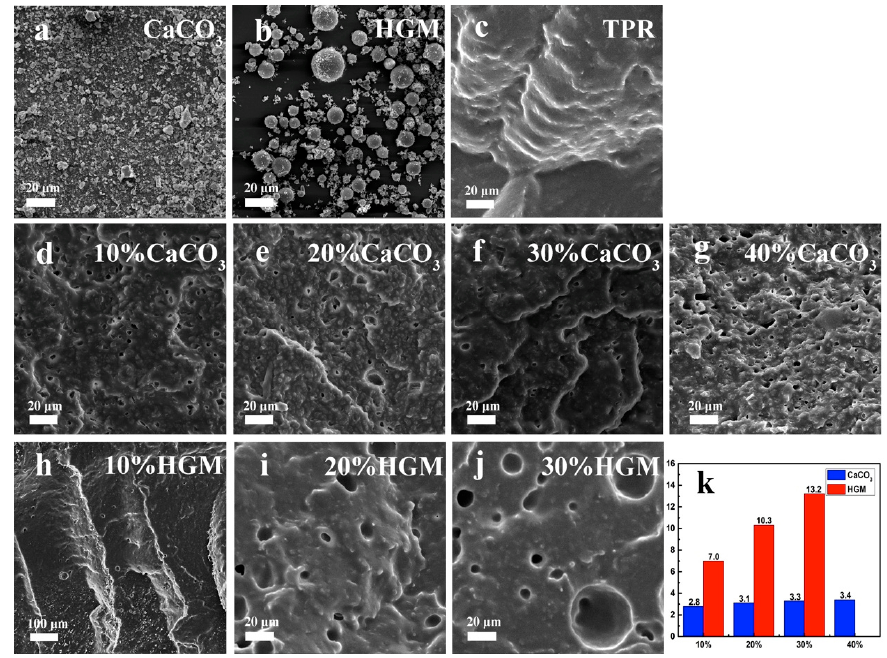
Figure 2. The morphology of inorganic particles and various TPR composites observed by SEM (the magnification ratio was 1000 times). ( a ) micro CaCO 3 ; ( b ) HGM; ( c ) pure TPR; ( d ) TPR/10%CaCO 3